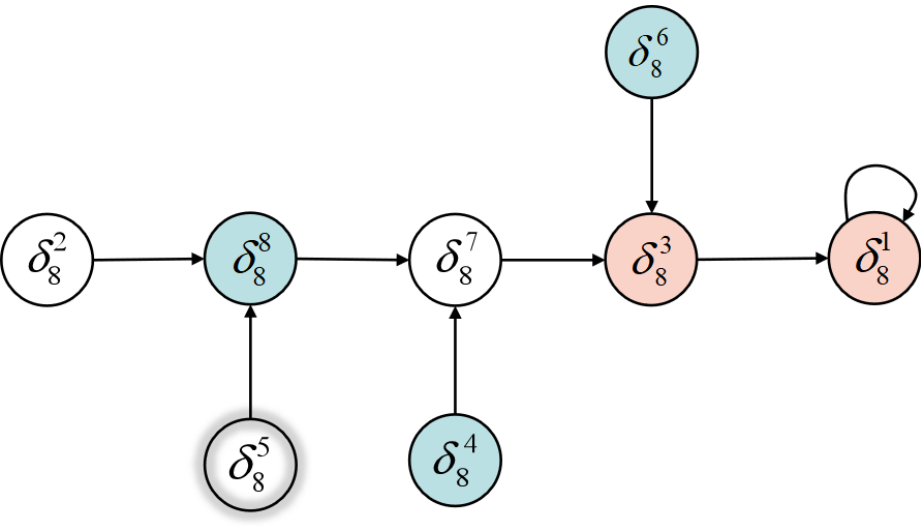
Figure 1. The state transition diagram of Example